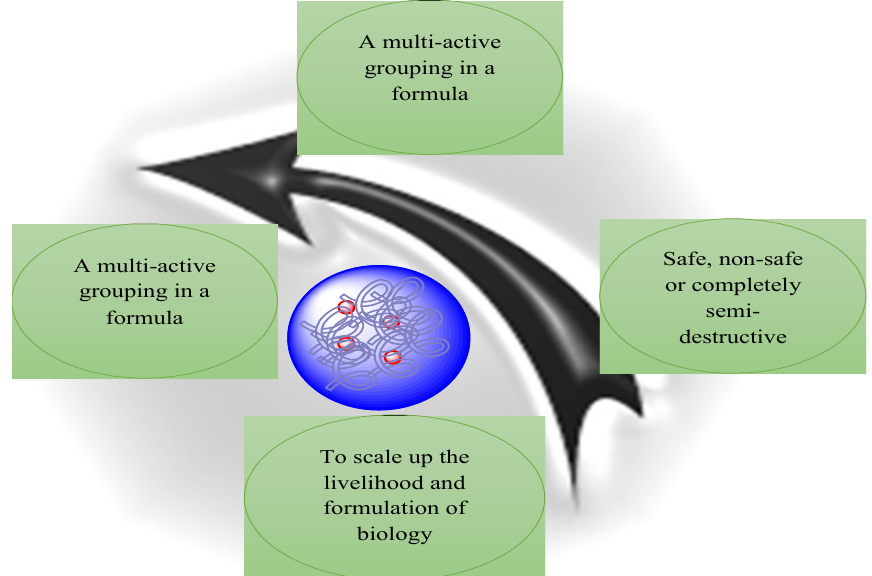
Fig. 1. advantages formulating of